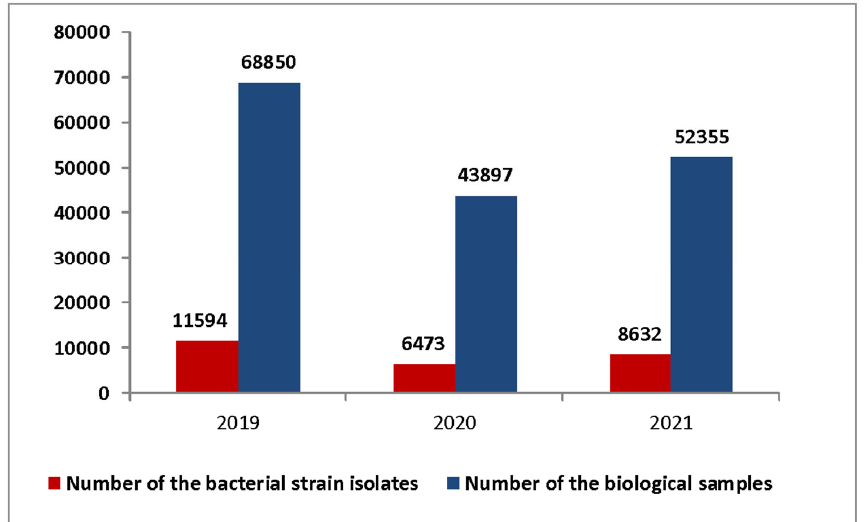
Figure A1. Annual evolution of the bacterial strain isolates and number of the biological samples in Galati, Romania (2019–2021).